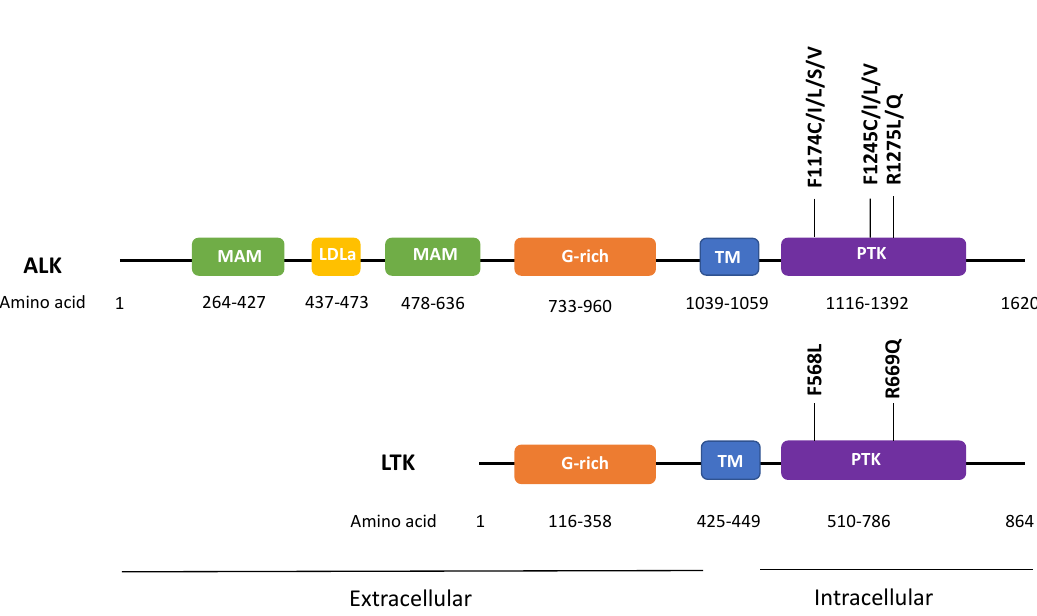
Figure 1. Recurrent oncogenic mutations of ALK and corresponding transforming mutations in leukocyte tyrosine kinase ( LTK ). F1174, F1245, and R1275 are three most common mutation sites of ALK oncogenic mutations in neuroblastoma; F568L and R669Q in LTK correspond to ALK F1174L and R1275Q mutations. meprin / A5-protein / PTPmu (MAM), low density lipoprotein class A (LDLa), G-rich, transmembrane (TM), protein tyrosine kinase (PTK) domains are shown.